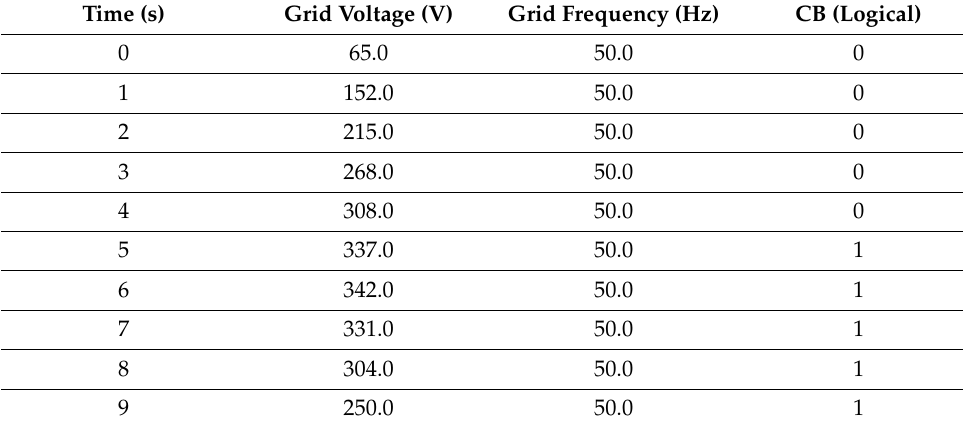
Table 9. Grid and circuit breaker status in OVP